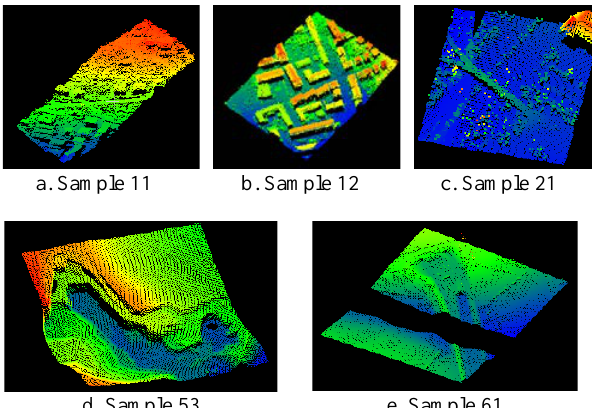
Figure 6. ISPRS testing samples: (a) steep terrain, (b) dense buildings, (c) bridge, (d) height discontinuity and (e)